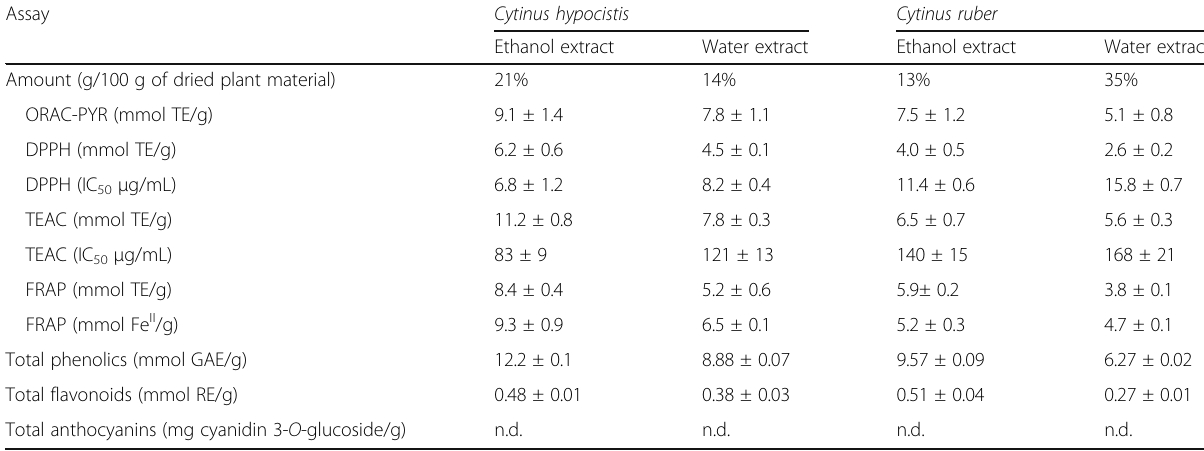
Table 1 Total antioxidant capacity of Cytinus hypocistis and Cytinus ruber extracts Assay Cytinus hypocistis Ethanol extract Water extract Amount (g/100 g of dried plant